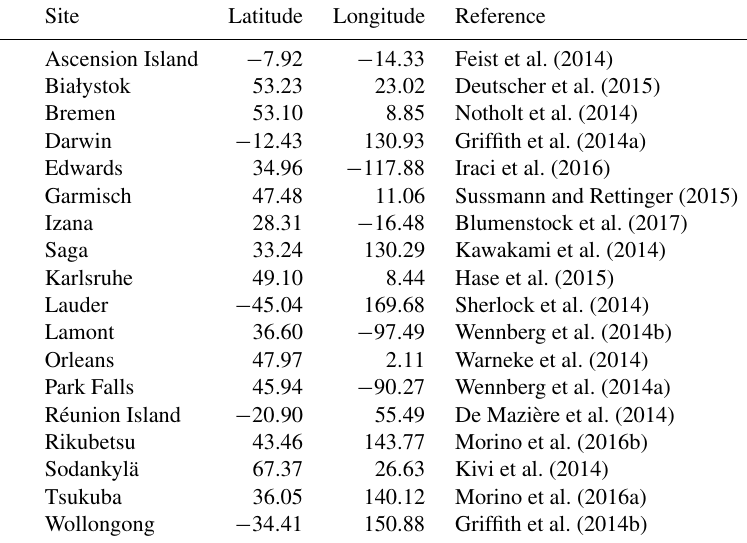
Table 7. TCCON stations used for model evaluations.